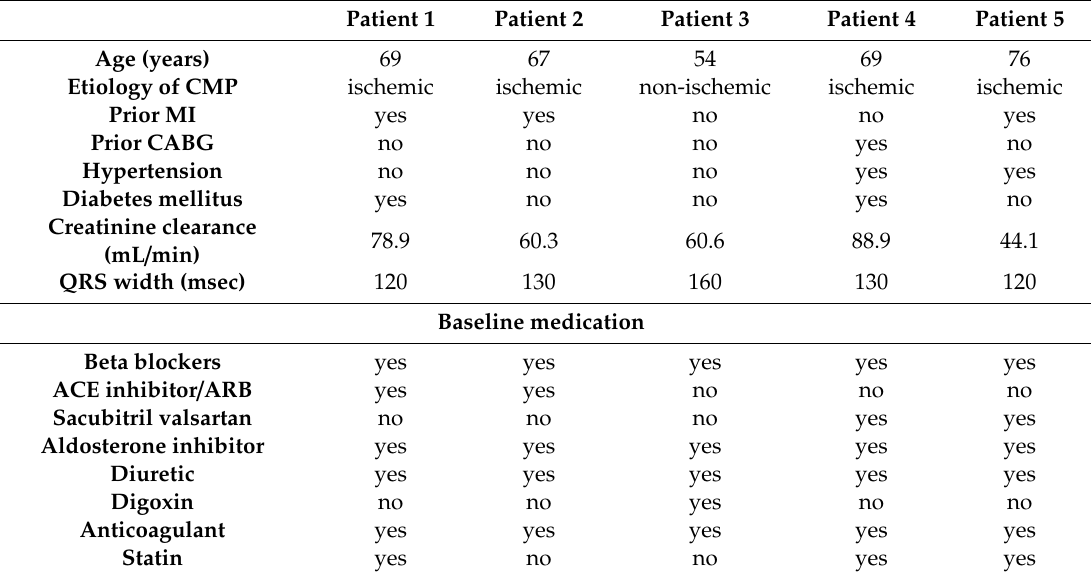
Table 1. Baseline demographics and